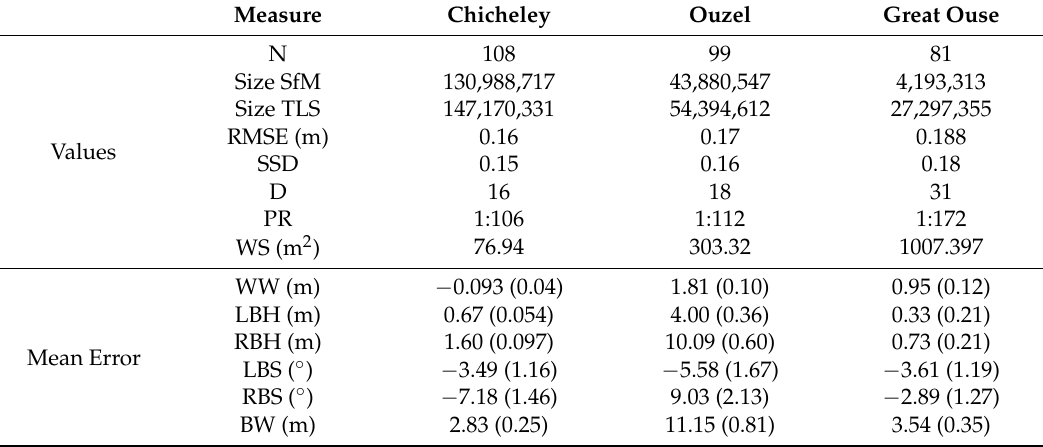
Table 8. Estimated mean error of the Structure from Motion (SfM) derived hydromorphological measures with respect to the Total Laser Scanner (TLS) measures for the 40 m long reaches at the Chicheley Brook, River Ouzel and River Great Ouse sites. The measures reported refer to: point cloud size (size), minimum number of cross-sections included in the calculations (N), the root mean square error (RMSE) of distance measurements between the SfM and TLS point clouds, surface standard deviation (m) (SSD) [44], distance (m) (D) [44], precision ratio (PR) [44], water surface area (WS), wetted water width (WW), left bank height (LBH), right bank height (RBH), left bank slope (LBS), right bank slope (RBS) and bank width (BW). Values in brackets represent the standard